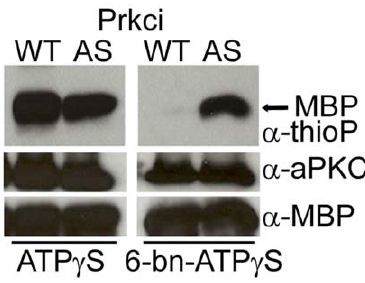
Figure 3. Mutant Prkci I316A uses bulky N 6 -benzyl ATP c S. Kinase reaction with Myelin Basic Protein (MBP) and ATP c S or N 6 -benzyl ATP c S (6-bn- ATP c S), followed by PNBM alkylation. In comparison, only mutant Prkci I316A efficiently utilizes N 6 -benzyl ATP c S to thiophosphorylate MBP. Labeled MBP is detected by Western blot analysis with rabbit monoclonal anti-thiophosphoester antibody ( a